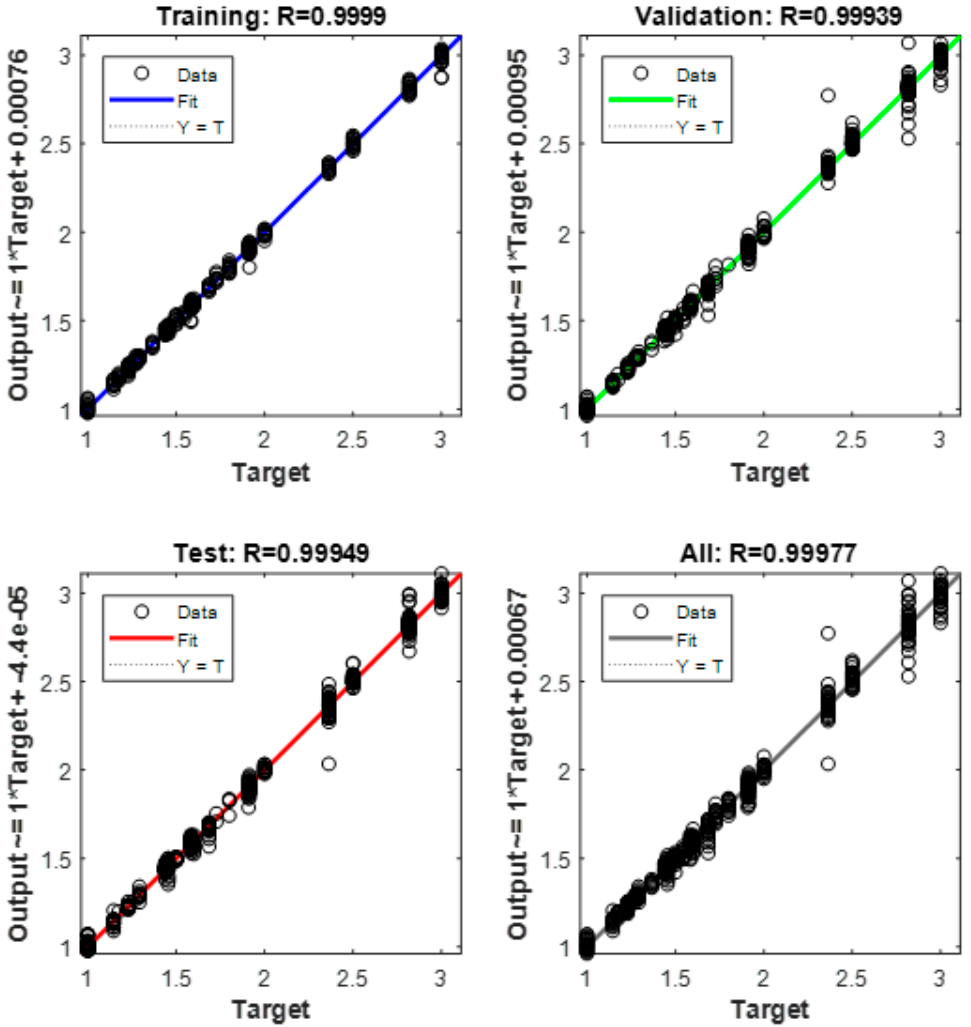
Figure 12. Data correlation in ANN (artificial neural networks) training, testing and validation.